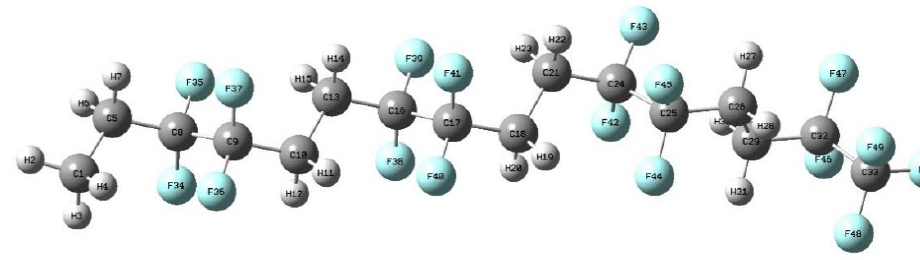
Figure 2. Molecular chain configuration of PVDF crystalline phase.